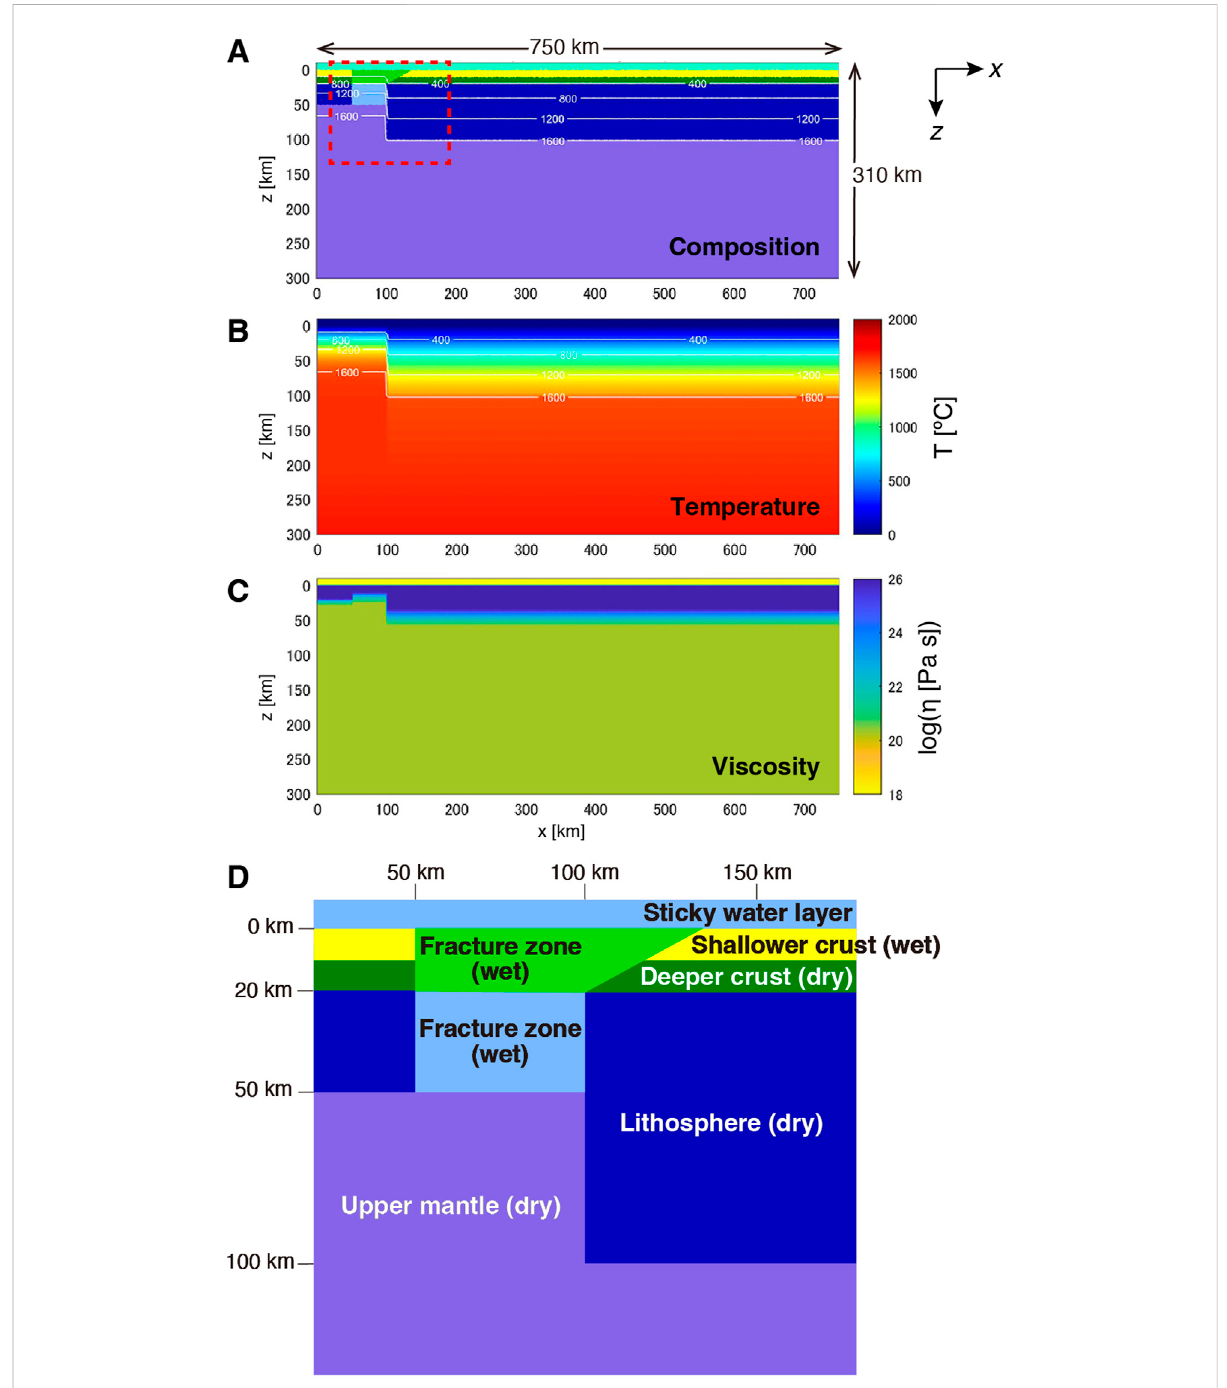
FIGURE 6 Initial condition for the numerical simulation. (A) Composition fi eld (B) temperature fi eld (C) viscosity structure, and (D) a close-up view of the areaenclosed bythedashedred rectangle in (A) .The computationaldomain comprisedshallower and deepercrustallayers with thesamethickness of 10 km and the underlying lithosphere with a variable thickness: the depths of the bottom of the right and left lithospheres were set to 100 km and 50 km, respectively. White contours represent isotherms with a contour interval of 400 ° C.